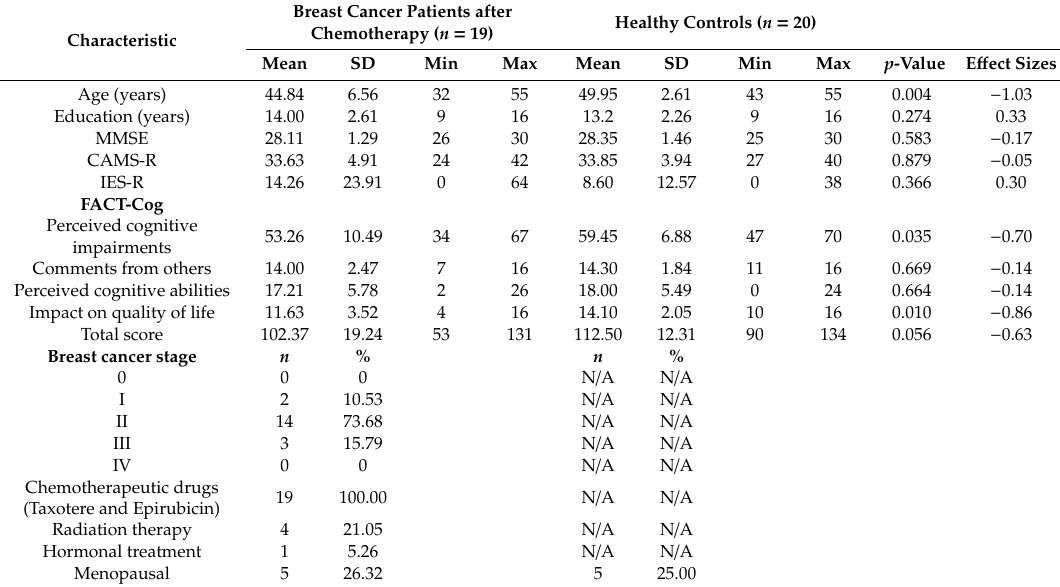
Table 1. Demographic characteristics and summary of neuropsychological testing and questionnaire evaluation of the all participants in the